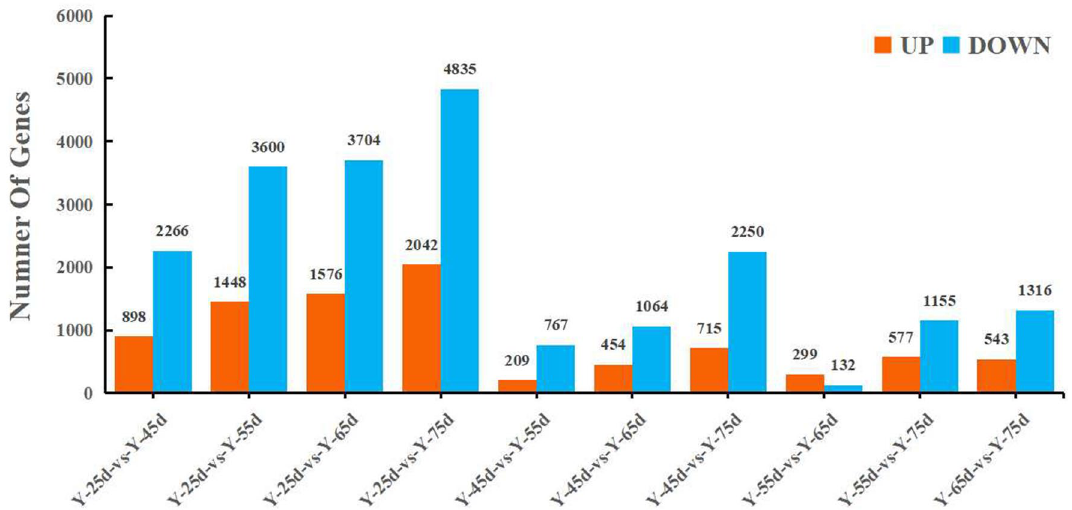
Figure 2. Number of DEGs. Y-25d: callus at 25 days; Y-45d: callus at 45 days; Y-55d: callus at 55 days; Y-65d: callus at 65 days; Y-75d: callus at 75